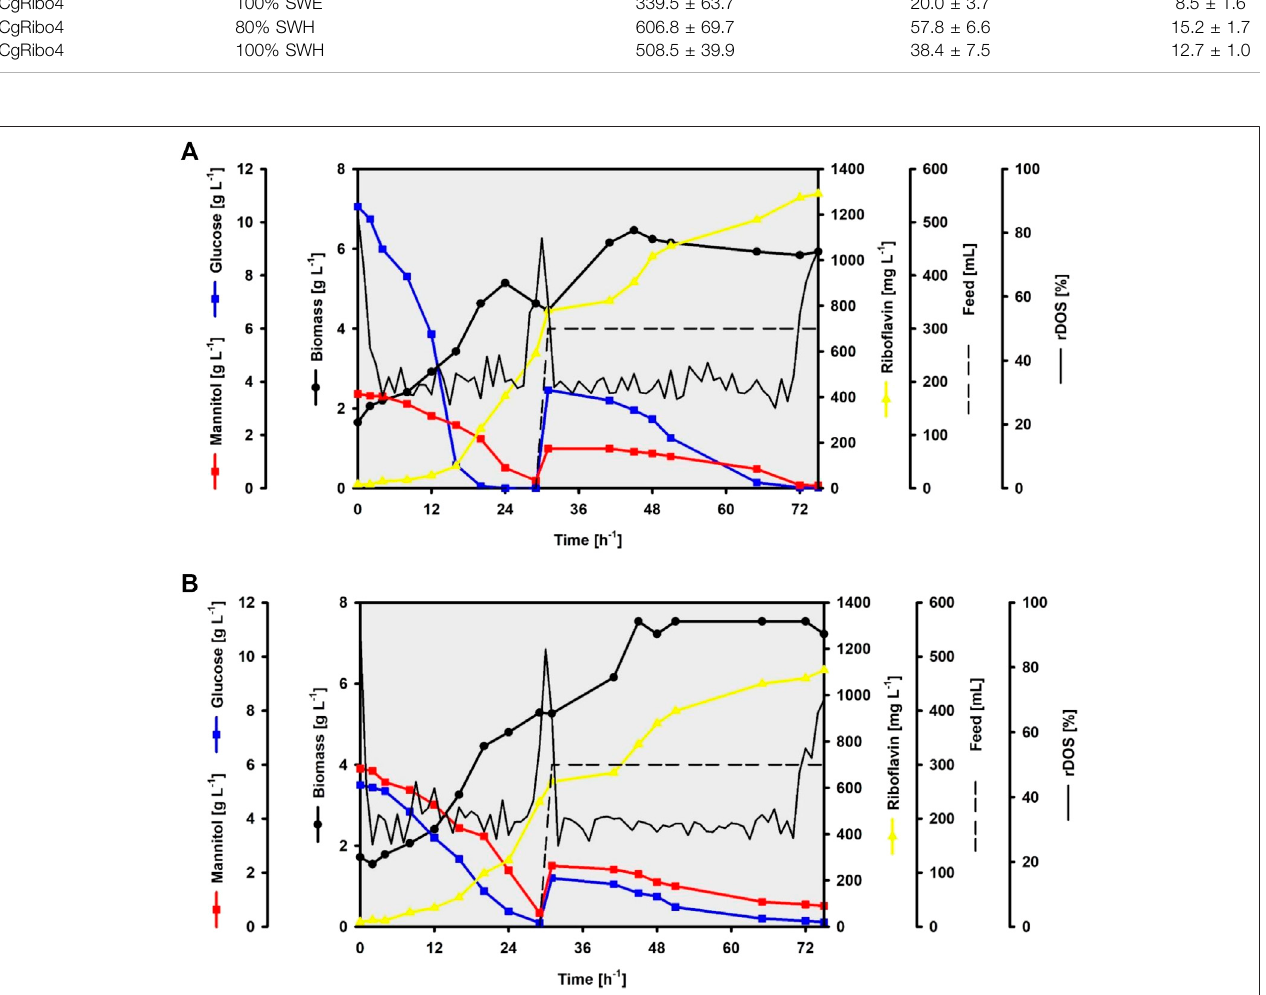
FIGURE 8 | Fed-batch fermentations of the strain CgRibo4 using brown seaweed-based substrates. Glucose and mannitol concentrations are depicted with blue andredlines,respectively.Biomassconcentrationsaredepictedwithblackcircles.Ribo fl avinconcentrationsaredepictedwithyellowlines.TherDOSlevelsaredepicted with black lines. Feed supplementations are depicted with dashed black lines. (A) SWE-based process. (B) SWH-based process.